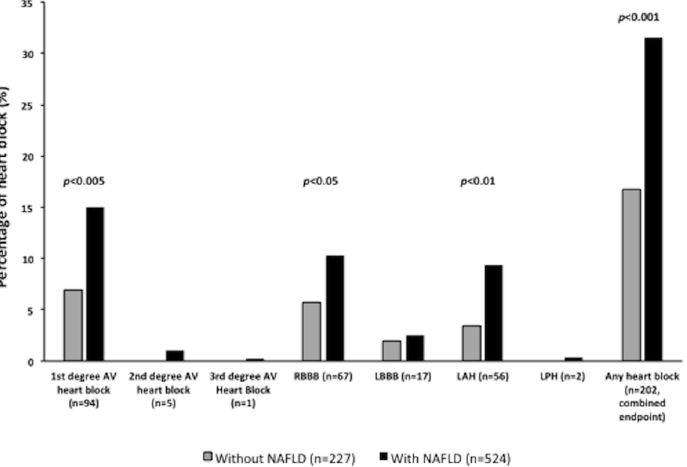
Fig 2. Prevalence of heart block in NAFLD. Prevalence of different types of heart block (singly or in combination) on resting 12-lead electrocardiograms in patients with T2DM stratified by NAFLD status. In the figure have been reportedonly the p values for the inter-group differences that were statistically significant.